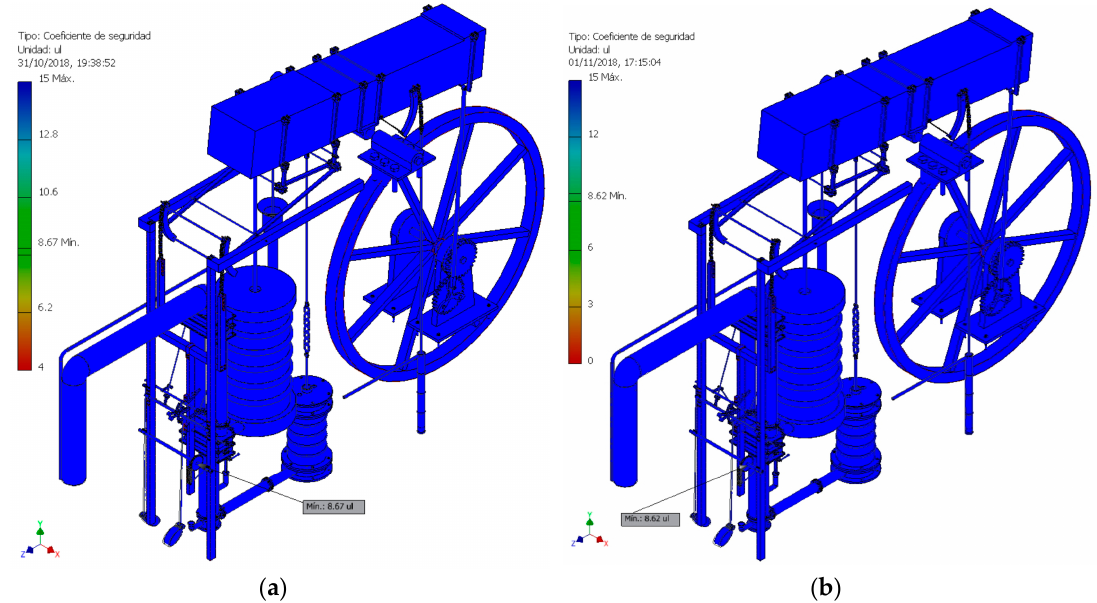
Figure 19. Second lowest safety coefficient: ( a ) downward movement and ( b ) upward movement.